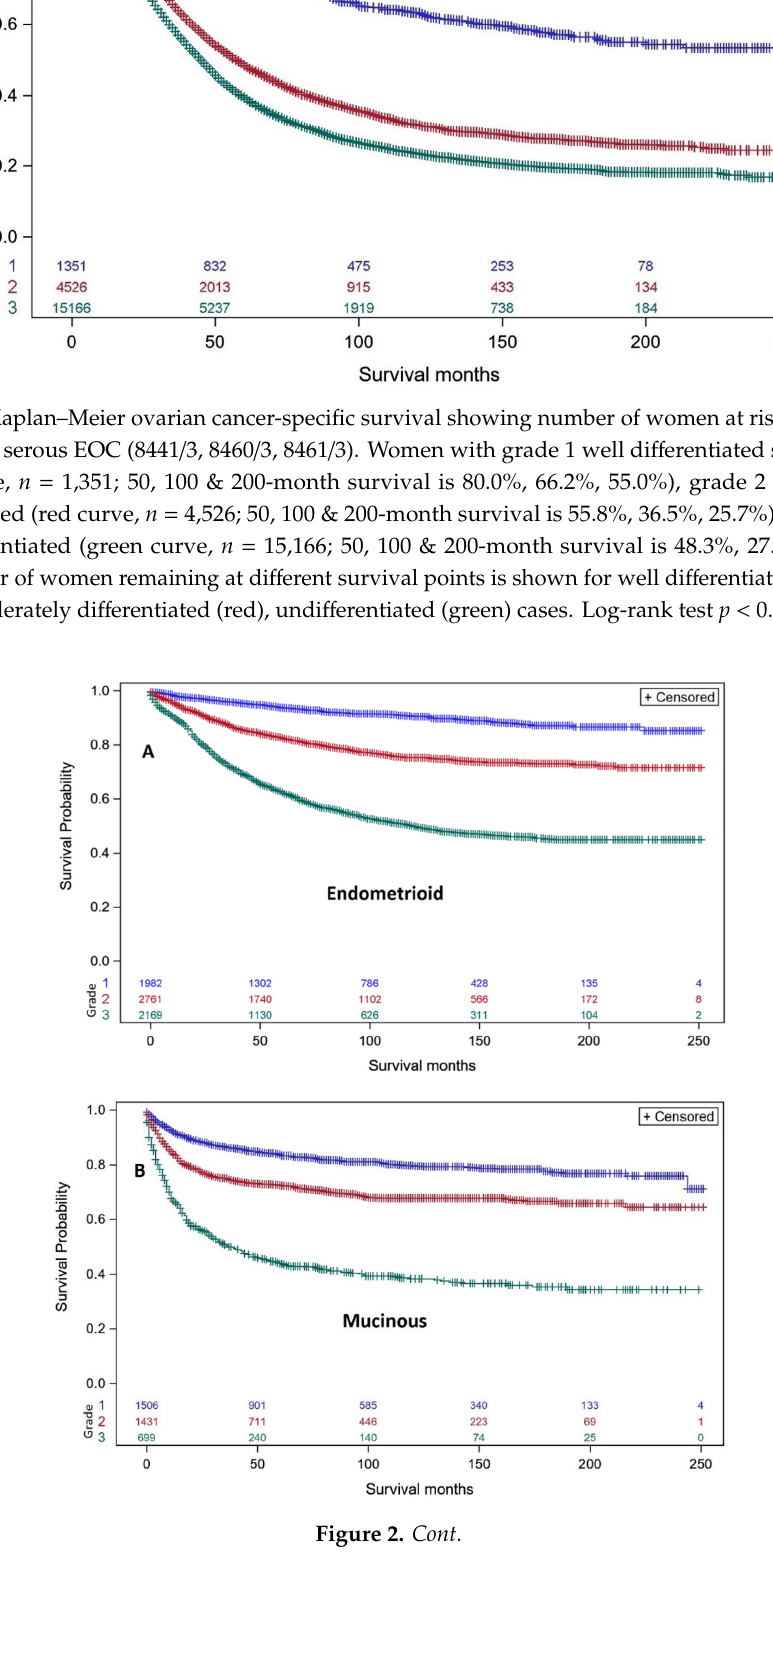
Figure 2. Kaplan–Meier ovarian cancer-specific survival showing number of women at risk according to grade of endometrioid EOC, mucinous carcinoma and clear cell EOC. ( A ). Women with endometrioid EOC (8380/3) that was grade 1 well differentiated (blue curve, n = 1,982; 50, 100 & 200- month survival is 94.8%, 91.4%, 86.5%), grade 2 moderately differentiated (red curve, n = 2,761; 50, 100 & 200-month survival is 84.3%, 77.1%, 71.7%), and grade 3 undifferentiated (green curve, n = 2,169; 50, 100 & 200-month survival is 66.4%, 52.9%, 44.4%). Log-rank test p < 0.001. ( B ). Women with